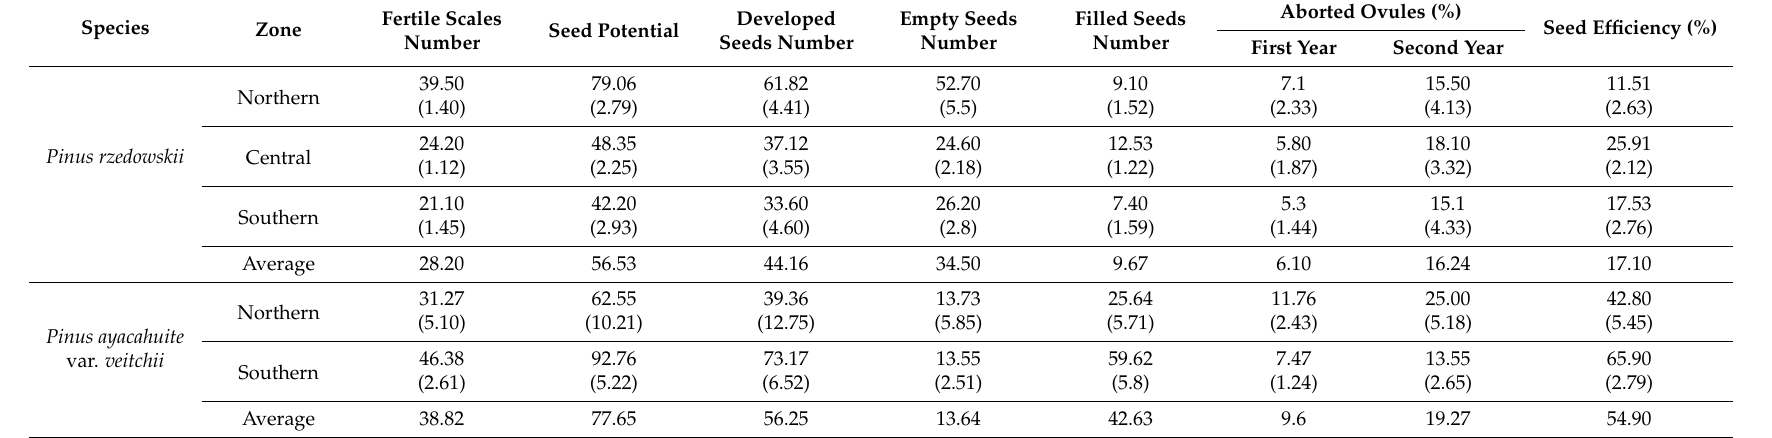
Table 2. Least square means and standard error ( ± SE) for cone and seed reproductive indicators of P. rzedowskii and P. ayacahuite var. veitchii , zones.